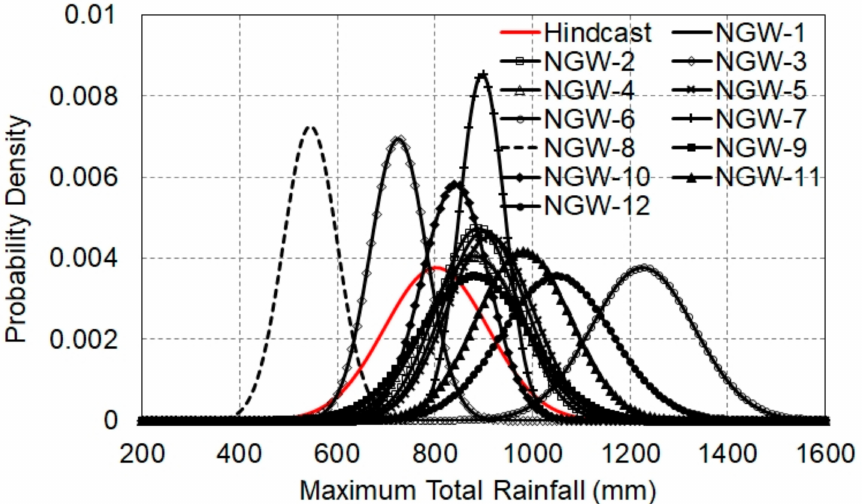
Figure 10. Probability density curves of the maximum total rainfall in D03 (R MAX ). The horizontal axis is R MAX (mm). The vertical axis is the probability